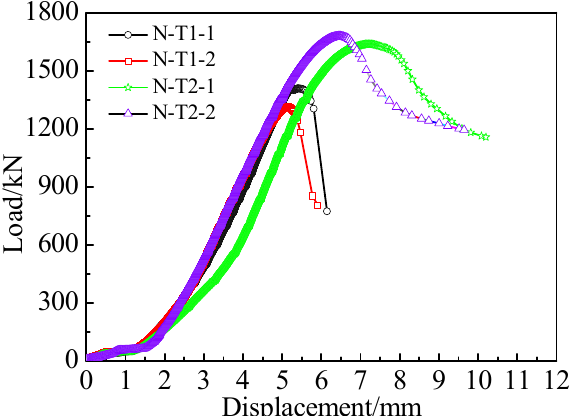
Figure 3. The relationships between load and displacement of the SCCFTST columns.